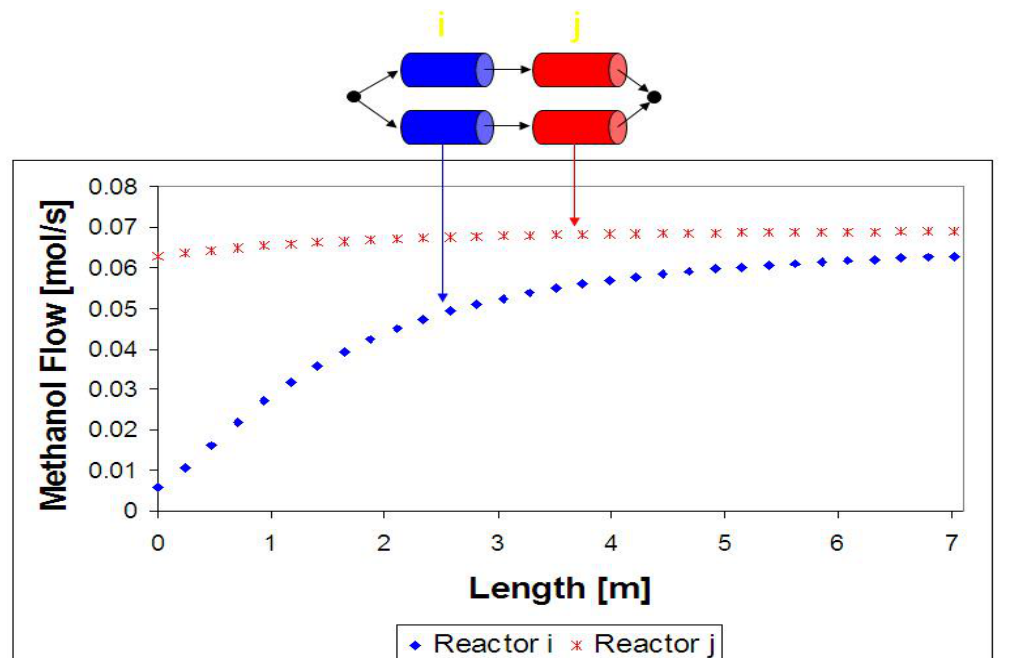
Figure 6. methanol molar flow profiles for optimal configuration at